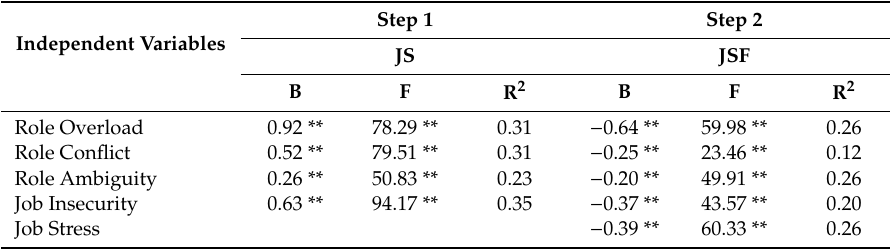
Table 2. Simple regression coe ffi cients for each individual